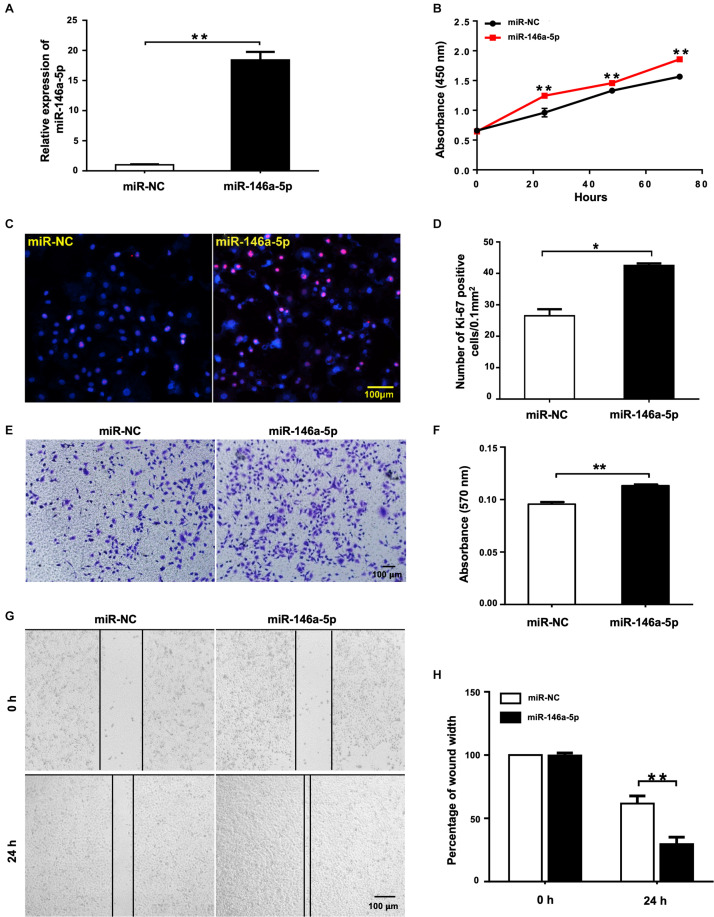
miR-146a-5p overexpression promotes cell proliferation and migration in NSCLC cells. Cell proliferation and migration measurement of A549 cells at 24 h post transfection of miR-146a-5p mimic or miR-NC. (A) The mRNA expression of miR-146a-5p measured by qRT-PCR. (B) Cell proliferation examined by CCK-8 assay. (C) Cell proliferation measured by Ki-67 staining. (D) Quantification of the Ki-67 staining assay result of (C). (E) Migration ability measured by transwell assay. (F) Quantification of the transwell assay result of (E). (G) Migration ability detected by wound-healing assay. (H) Quantification of the wound-healing assay result of (G).